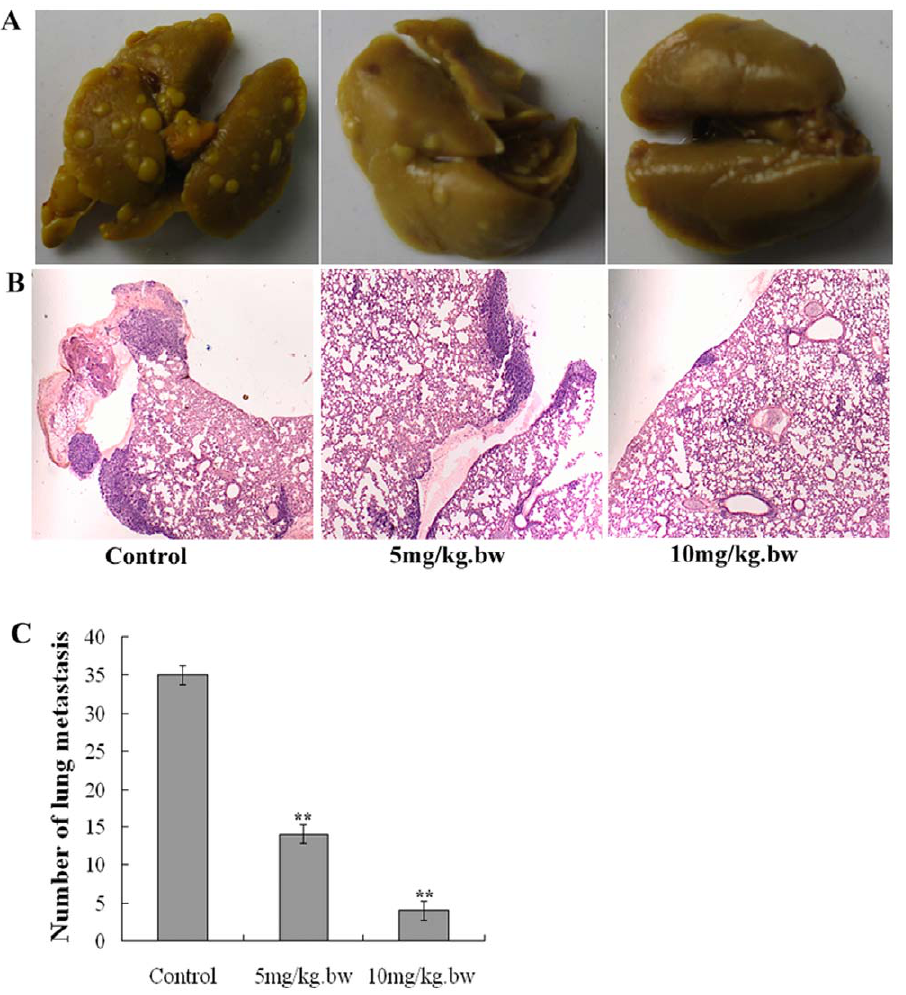
Figure 9. Fucoidan decreased lung metastases of breast cancer. A) Representative photographs of lung metastases after treatment of fucoidan. Mice were euthanized 20 days after treatment. Lungs were harvested, put in a fixative (saturated picric acid: formaldehyde: acetic acid =75:25:5) for 24 h, and then restore the color to the lung tissue by soaked in absolute alcohol. B) Photograph of Hematoxylin and eosin-stained sections in lung metastatic nodule ( 6 20 magnification). The deep blue dye cell mass was breast cancer metastases. C)The number of lung metastatic nodules (white) were counted. The results are presented as mean 6 SD (n=7 tumors). The results are presented as mean 6 SD (n=7 tumors). Compared with control mice, fucoidan resulted in significantly fewer lung metastases. ** P , 0.01 vs